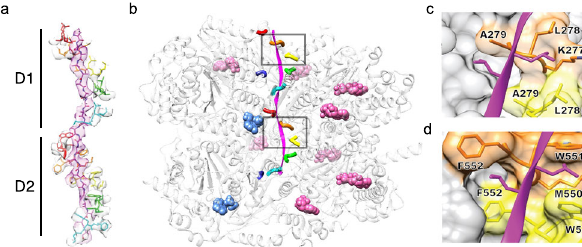
Fig. 3 Interactions between p97 and substrate in the central pore. a Side view of density and model of substrate (magenta) and pore loop 1 (subunit colors). b Side view of the p97 hexamer (ribbon) with pore loop 1 (subunit colors) and ATP (pink spheres) or ADP (blue spheres). Dashed boxes indicate closeup views in panels ( c ) and ( d ). c Closeup of the model showing the D1 substrate dipeptide binding units at the BC interface. The three other substrate-binding D1 subunit interfaces are very similar (i.e., AB, CD, and DE). Pore loop 1 residues are labeled. Substrate residues are modeled as leucine for clarity. d Equivalent to panel c for a substrate dipeptide binding in the D2 pore. Equivalent binding is observed at the other substrate-binding D2